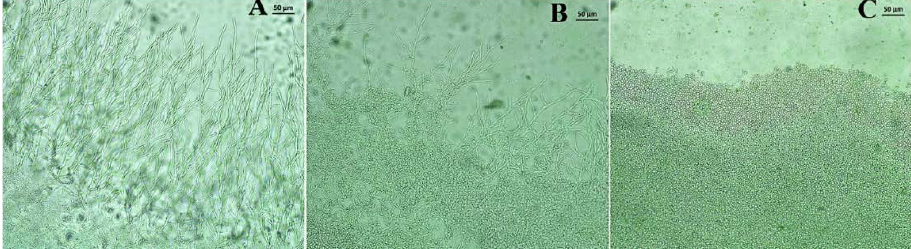
Figure 4. Optical microscopy images showing the effects of different treatments on the growth of fungal filaments. ( A ) Control; ( B ) nerolidol (CFM/8); ( C ) fluconazole CFM/8.